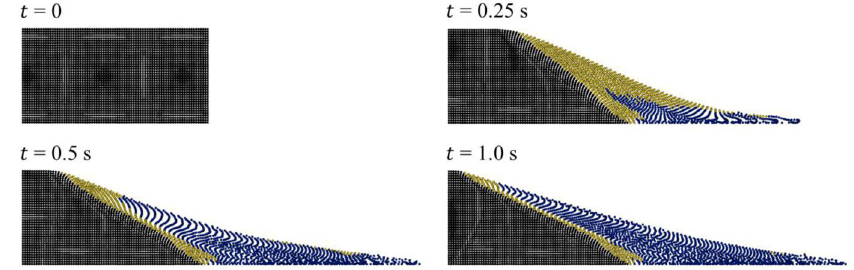
Fig. 15 Evolution of the semi‑Lagrangian (blue nodes) and transition (yellow nodes)